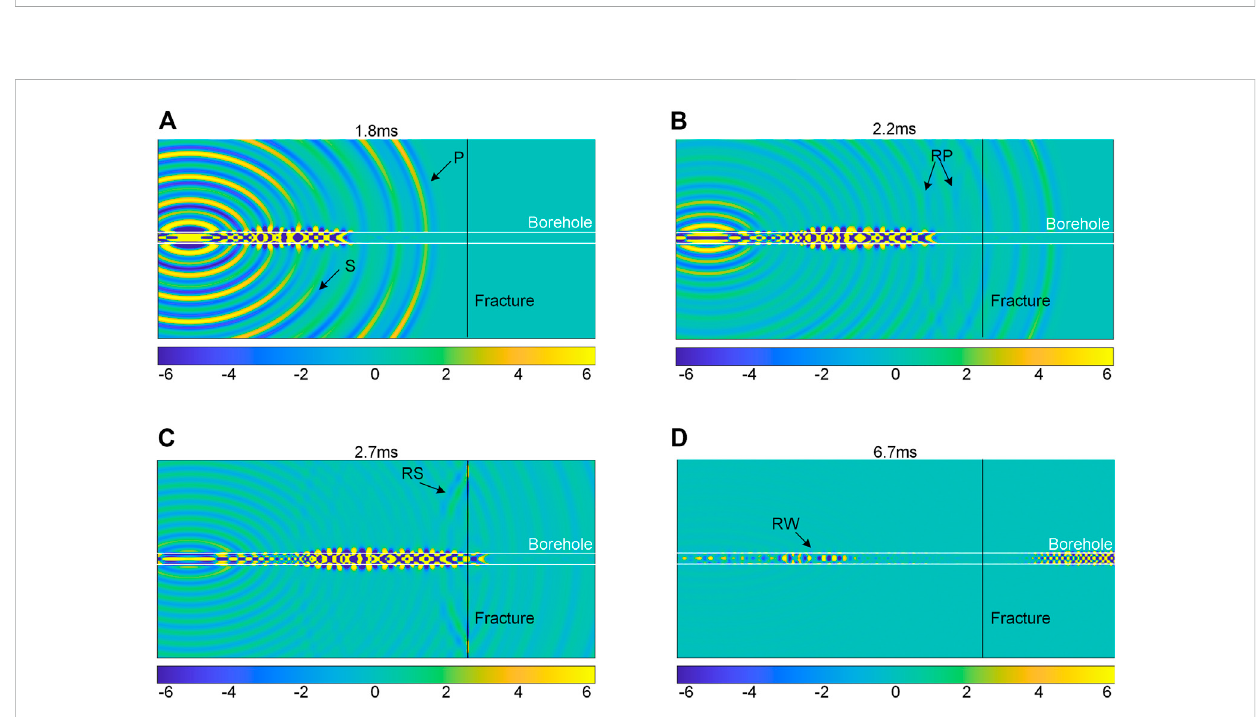
FIGURE 3 Wave fi eld slice of the full wave excited by a broadband monopole sound source. The color scale at the bottom of the fi gure describes the wave energy distribution. Yellow and blue respectively correspond to the peak and trough energy of the mode wave. The fracture dip angle is 90 ° , the fracture width is 40 mm and fi lled with calcite. (A) 1.8 ms; (B) 2.2 ms; (C) 2.7 ms; (D) 6.7